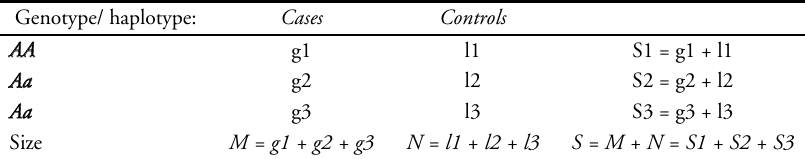
Case-control contingency table for allelic association study